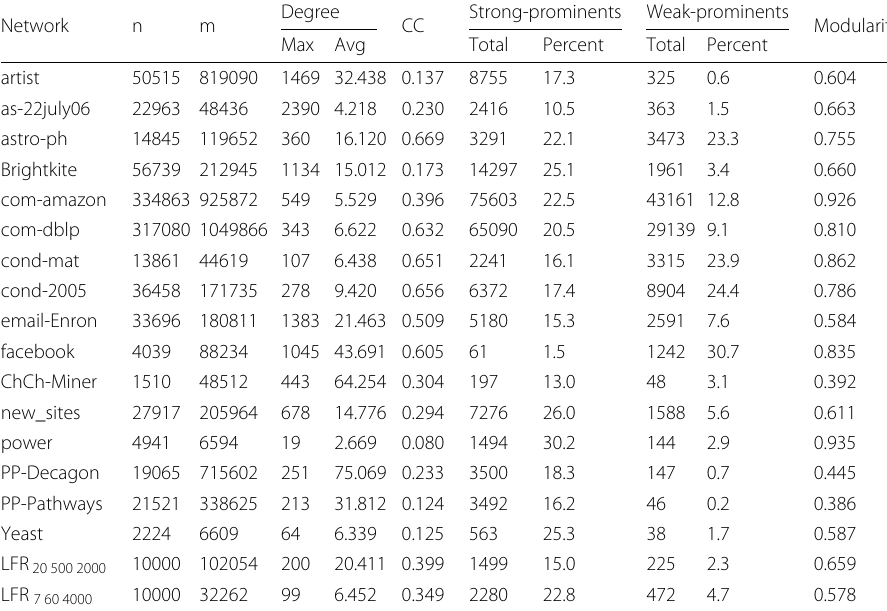
Table 11 Properties of real-world networks